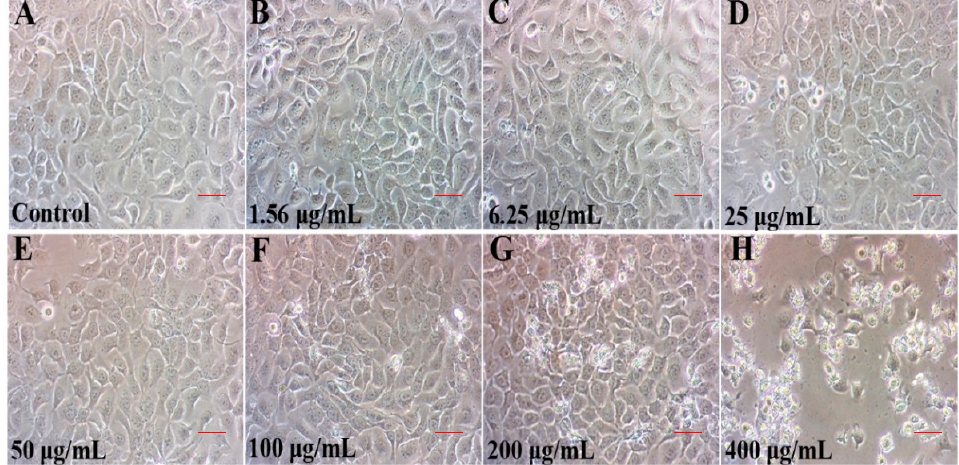
Figure 1. Cytotoxicity of TCPP on HaCaT cells after exposure to 1.56–400 μ g/mL TCPP for 24 h ( A ) and logarithmic transformation of TCPP concentrations and cell viability data to determine IC 50 ( B ). ** p < 0.01.